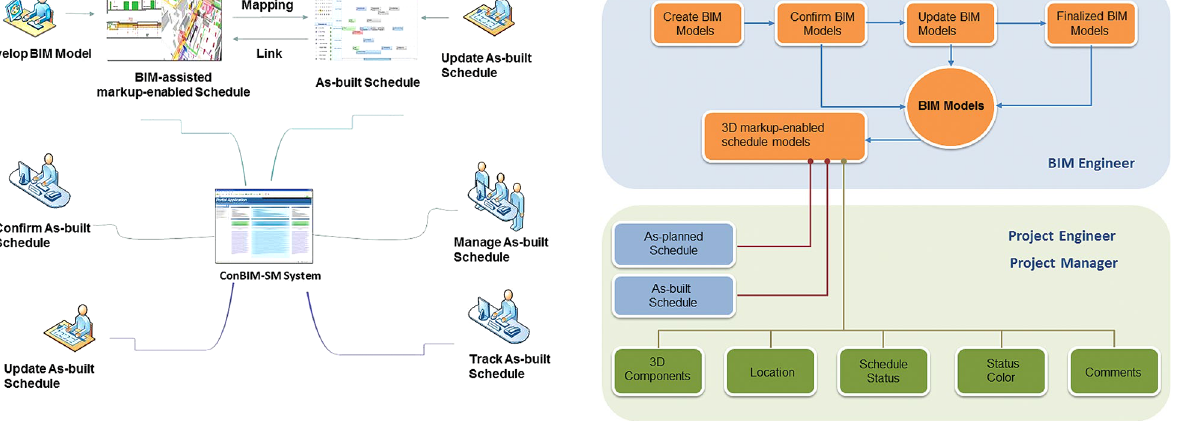
Fig. 1. The concept and framework of the ConBIM-SM system Fig. 2. Concept of BIM-assisted visualization integrated with the as-built schedule in the ConBIM-SM